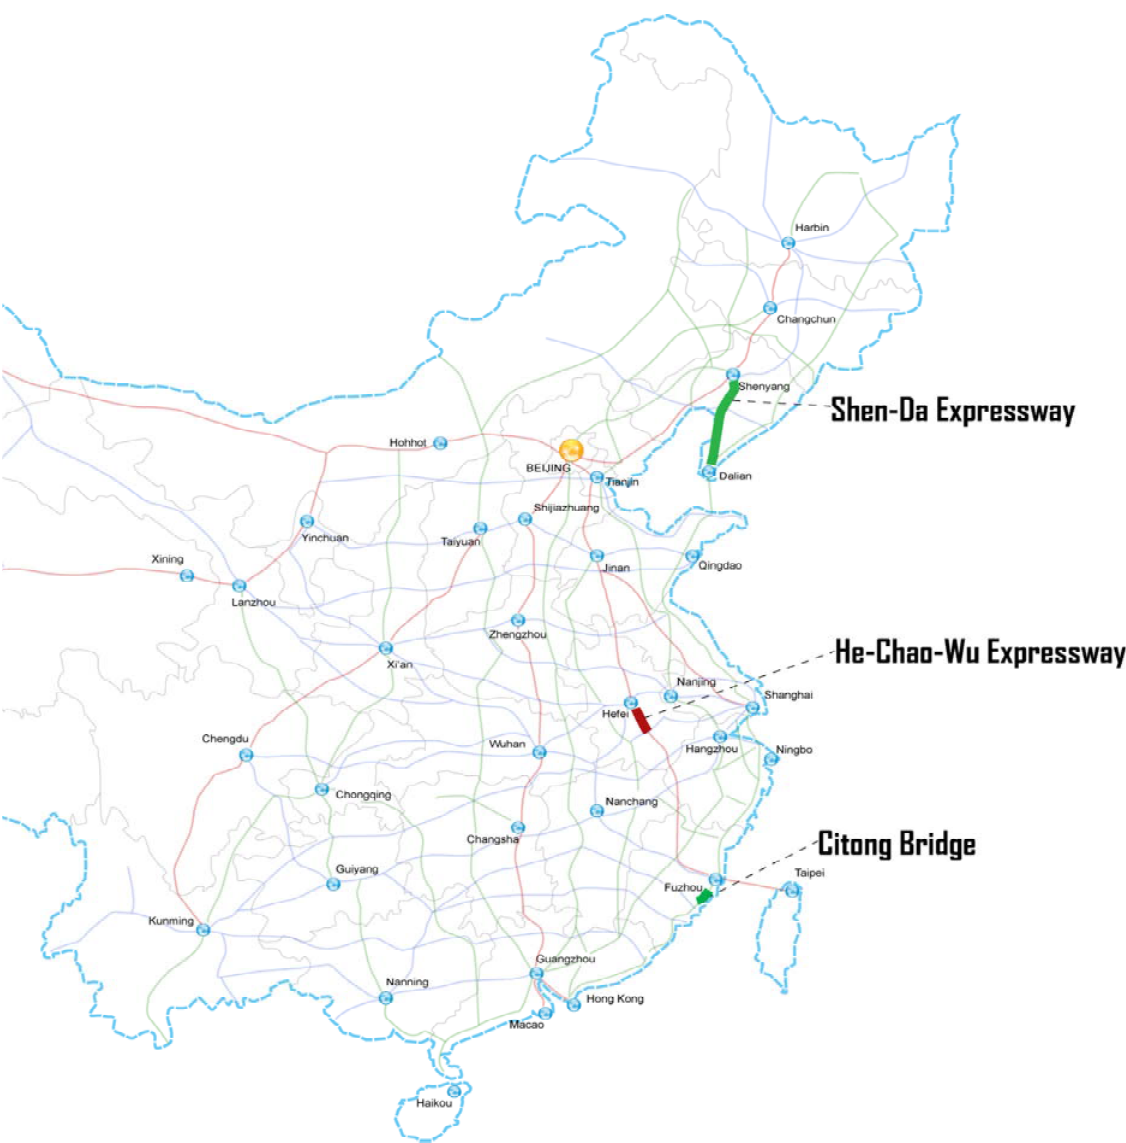
Figure 3. The Chinese plan for expressways and the selected cases